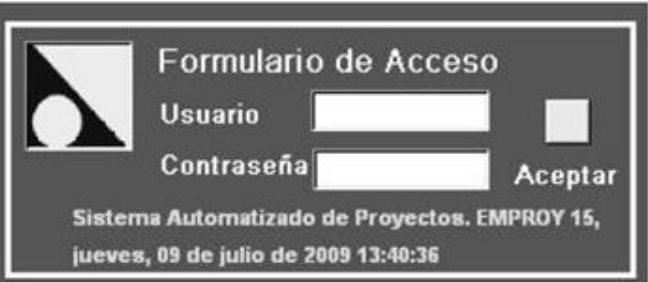
Figura 4: Formulario de acceso.